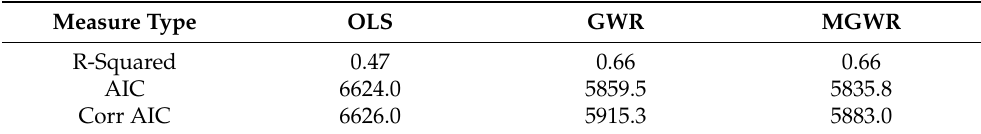
Table 3. Model fit measures for ordinary least squares (OLS) regression, geographically weighted regression (GWR), and multiscale geographically weighted regression (MGWR) predicting percent some college educational